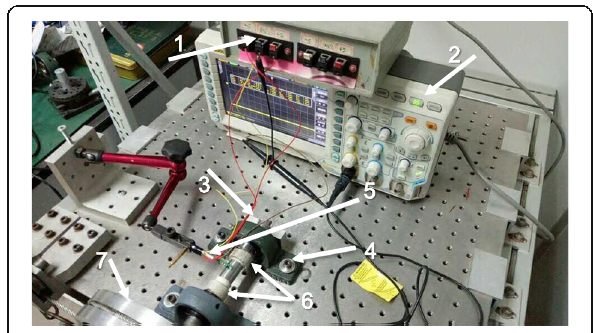
Fig. 2 The torque measurement device. (1) DC power supply, (2) oscilloscope, (3) fixed parts, (4) bearing, (5) non-contact signal extraction circuit, (6) permanent magnet ring, and (7) torque loading